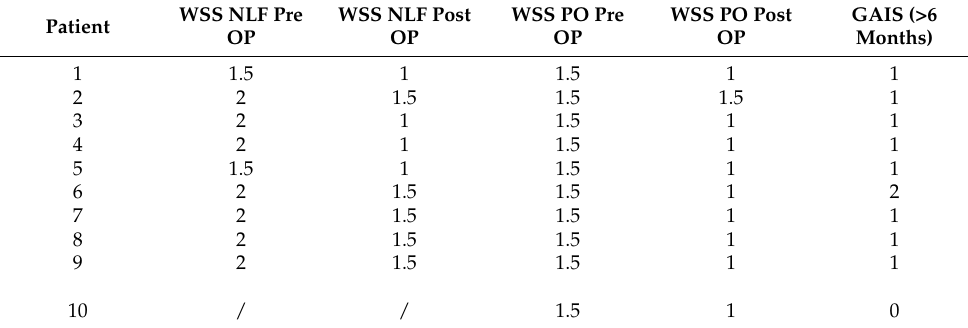
Table 3. Follow-up 12 months: Survey of patients undergoing lipofilling for rejuvenation for na- solabial and periorbital folds.